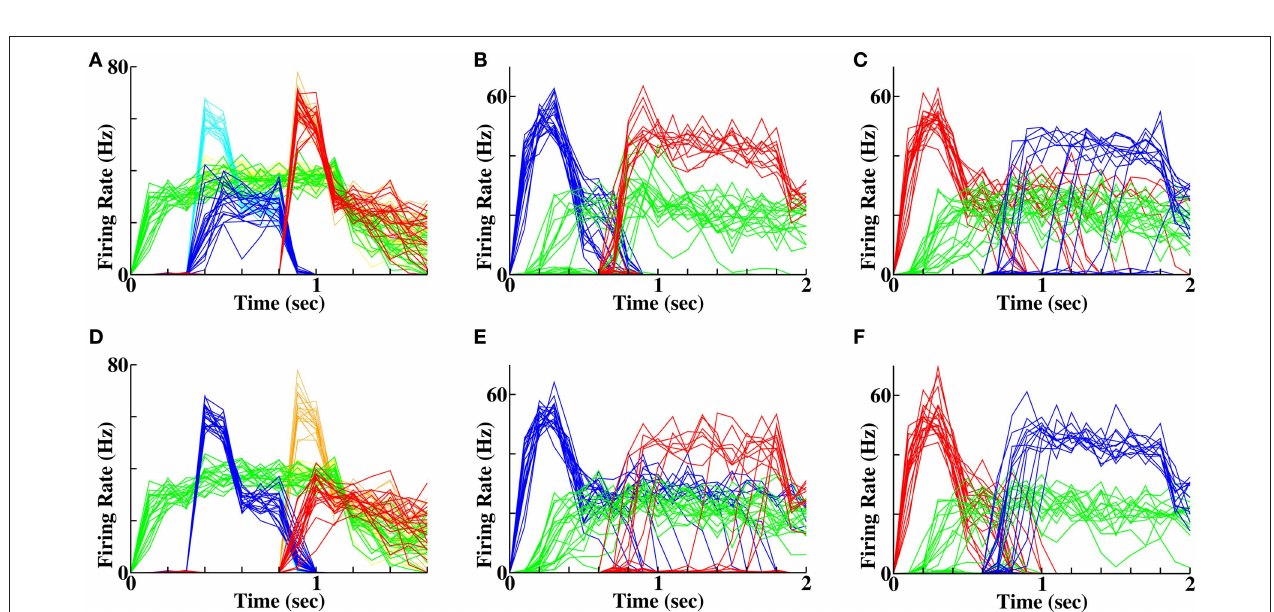
color scheme). (D) Set of spike rasters for an example error, where a population, which had not received prior stimulation, becomes activated. (e) Average activity of populations without prior stimulation (magenta) demonstrate multiple examples of error during forward recall (blue and green traces depict activity of first word, “BAT”, and context, “C1”, as in (B) ). (F) Average activity of populations without prior stimulation (magenta) demonstrate multiple examples of error during reverse recall (red and green traces depict activity of second word, “DIN”, and context, “C1”, as in (C) ).